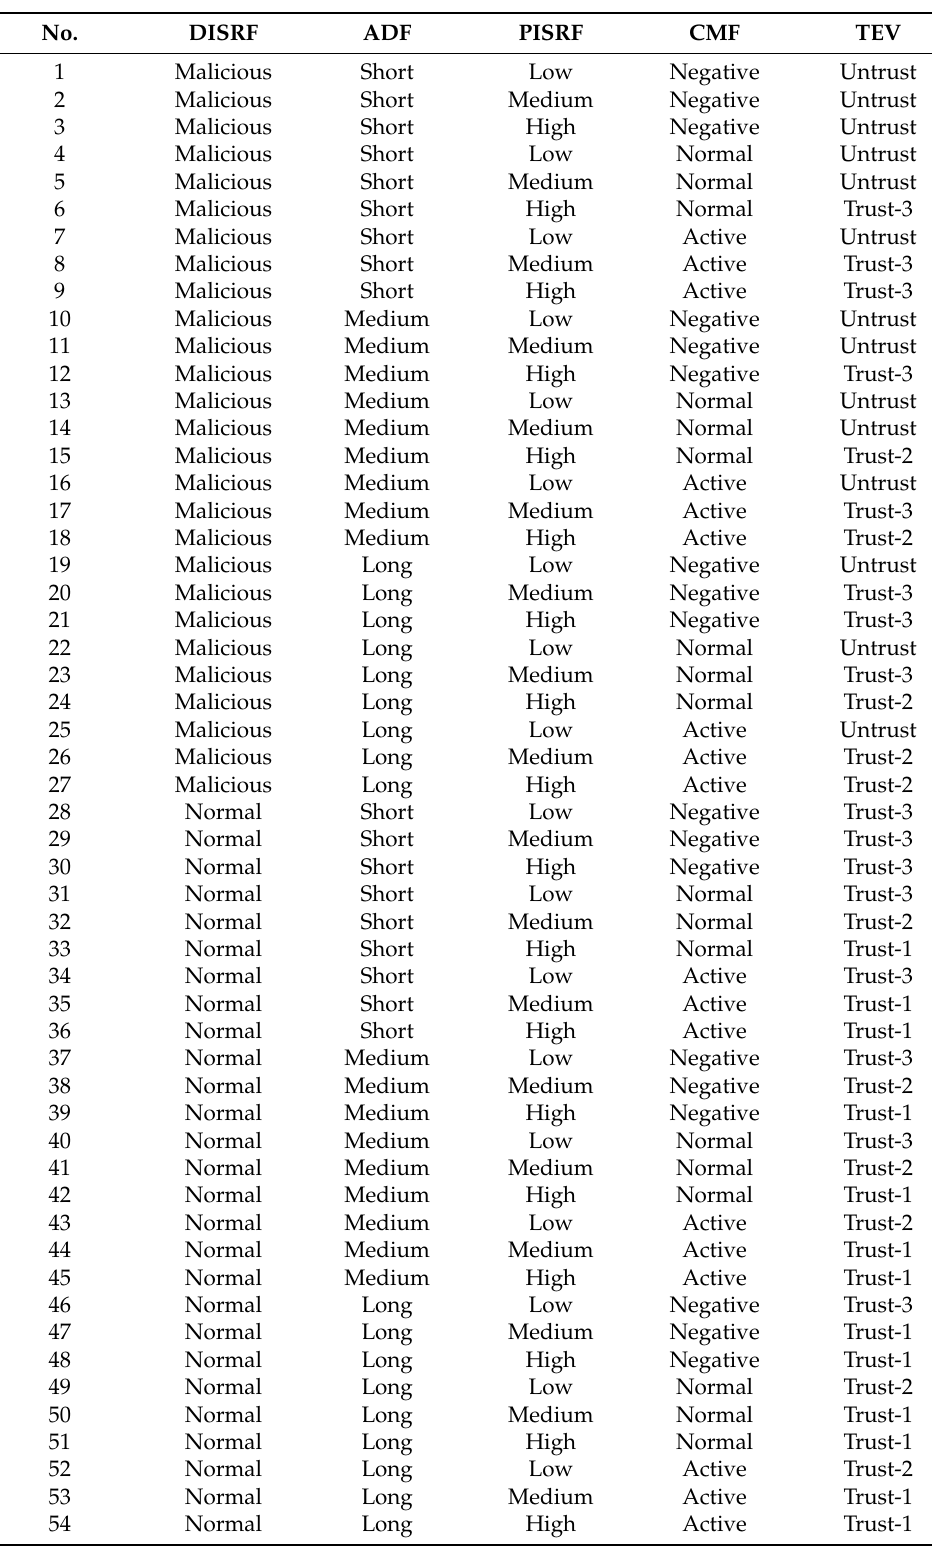
Table 1. Fuzzy logic